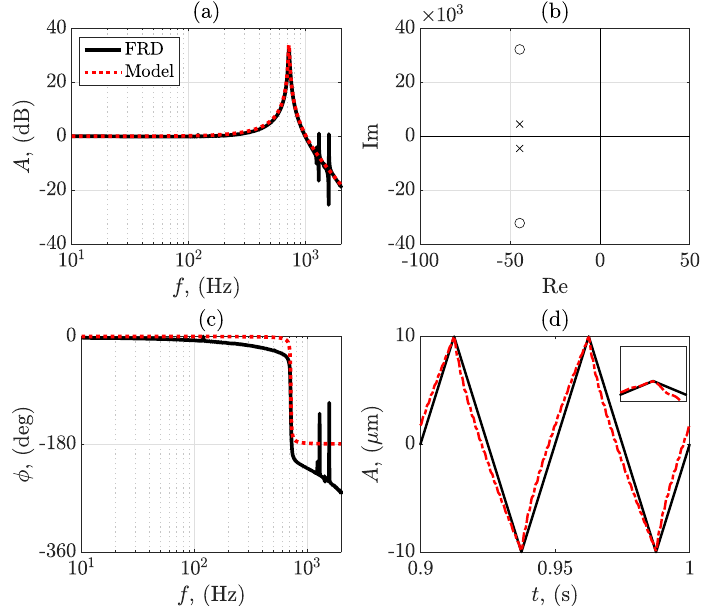
Figure 2. ( a ) The frequency amplitude response of the FRD and the developed second–order model. ( b ) The phase response of the FRD and model, respectively. ( c ) The pole-zero map of the second– order model. ( d ) represent the input signal, input signal and system response overlayed and the step response, respectively. The following table summarises the second–order model fitted to the FRD.